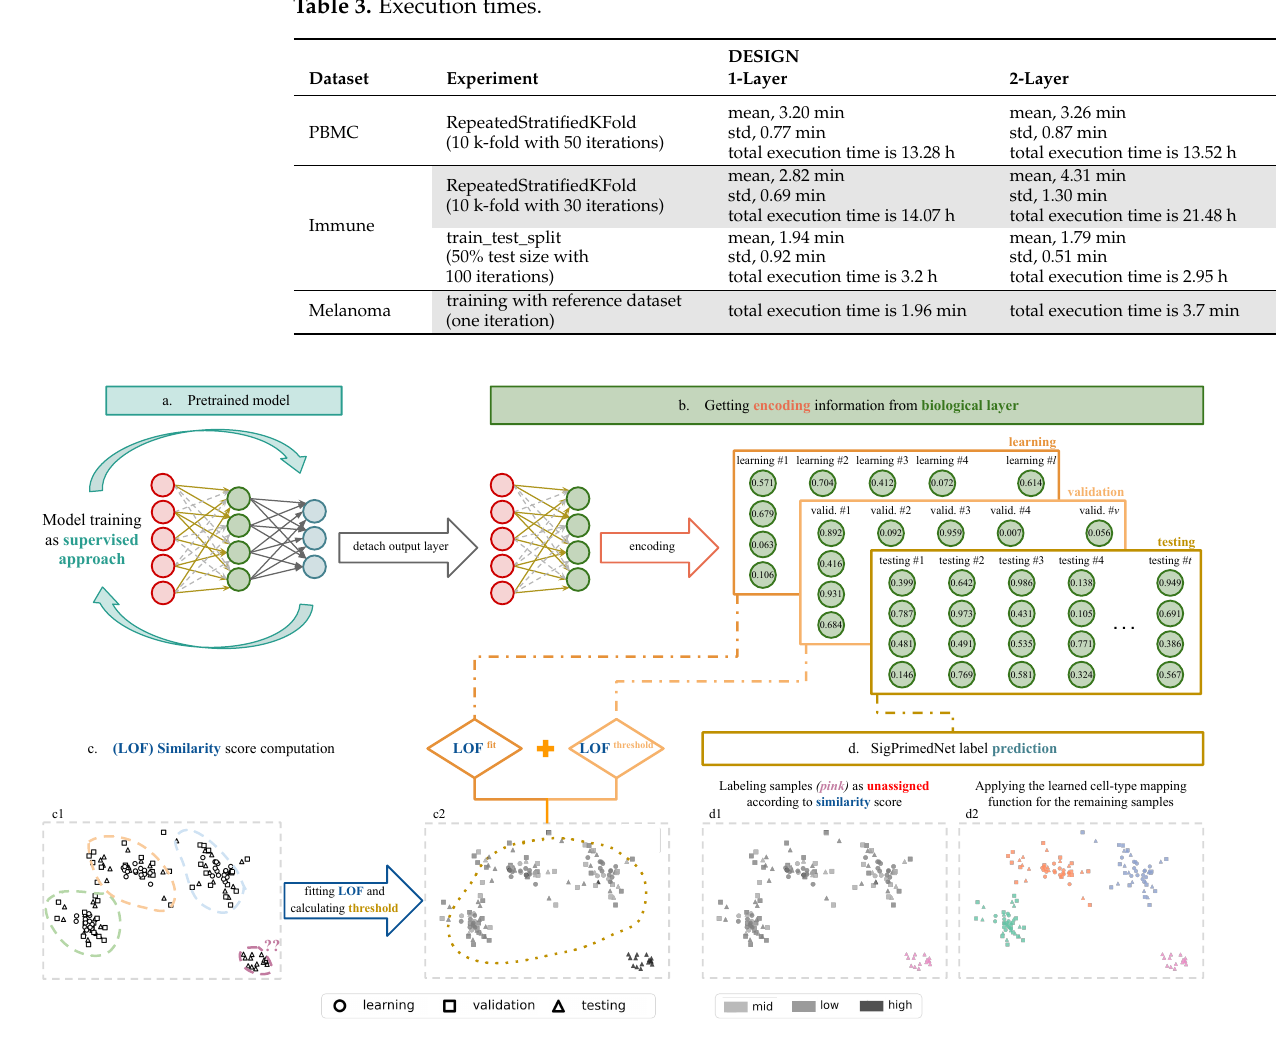
Figure 3. SigPrimedNet’s prediction mechanism (in two dimensions to simplify). Given the fitted NN ( a ), we detach the output layer and compute the encodings of the learning, validation and test sets ( b ), Then, in ( c1 ) we fit a LOF to model the training encodings, ( c2 ) predict the similarity scores of the learning and validation encodings to compute a more realistic threshold. Finally, ( d1 ) a sample is labeled as unassigned if its similarity score is bellow the threshold, if not ( d2 ) we apply the cell-type mapping learned by the